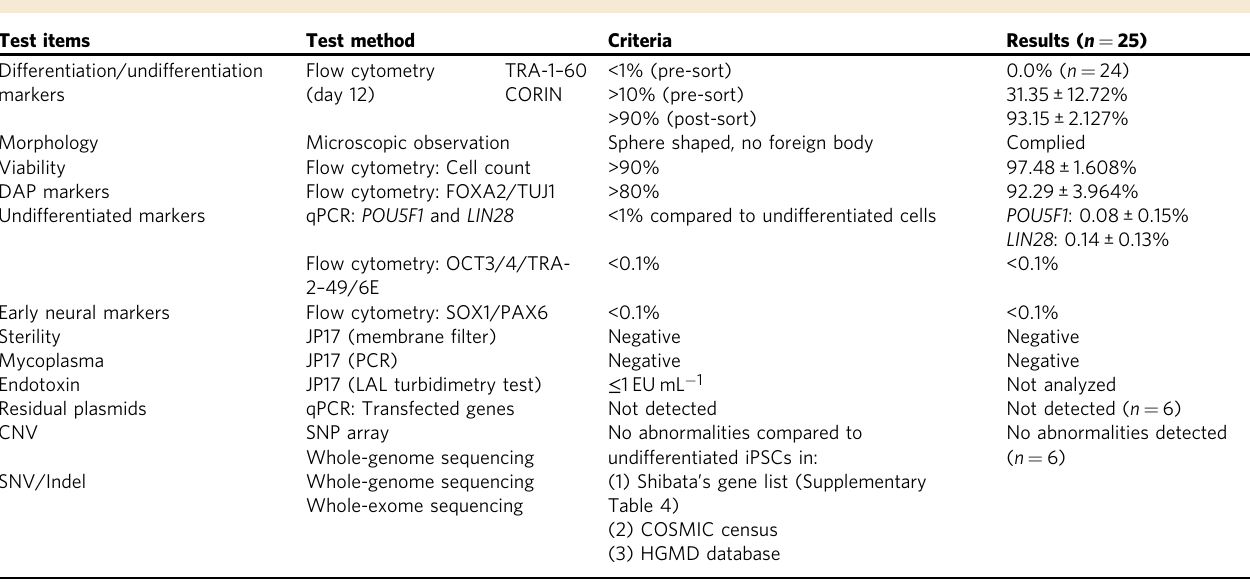
Table 1 Characterization of the fi nal